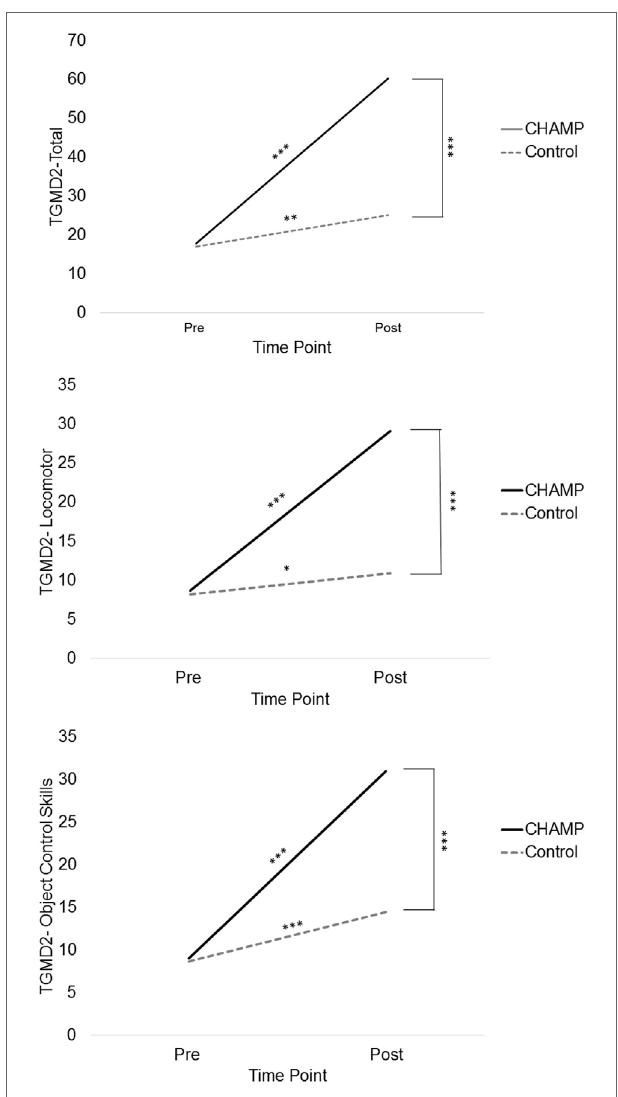
FigUre 1 | Total, locomotor, and object control skill scores across time according to treatment group